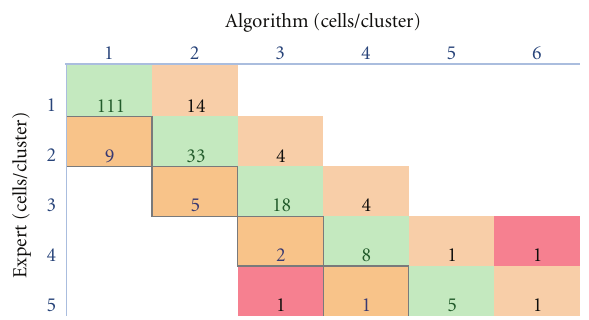
Figure 7: Contingency table analysis of algorithm accuracy on MSCs. In all cases but two, the algorithm was within ± 1 cells. The total number of cells counted by the expert was 393 compared to 386 by the algorithm. See Figure 6 for